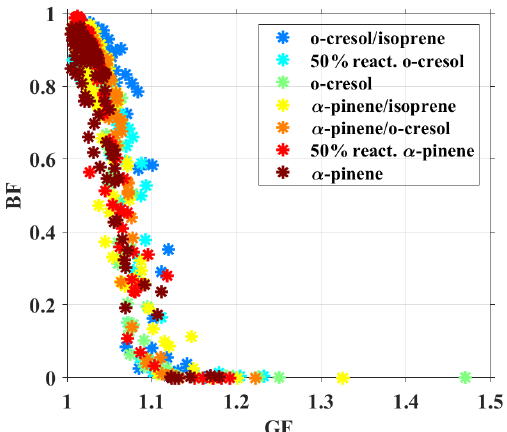
Figure 5. The relation of BF and hygroscopic GF of aerosol par- ticles during 6h photochemistry experiments in various VOC sys-